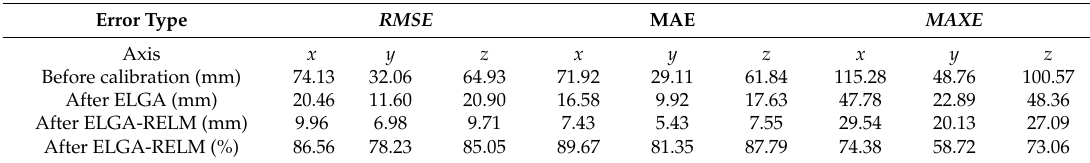
Table 4. The positioning error evaluations of on testing data